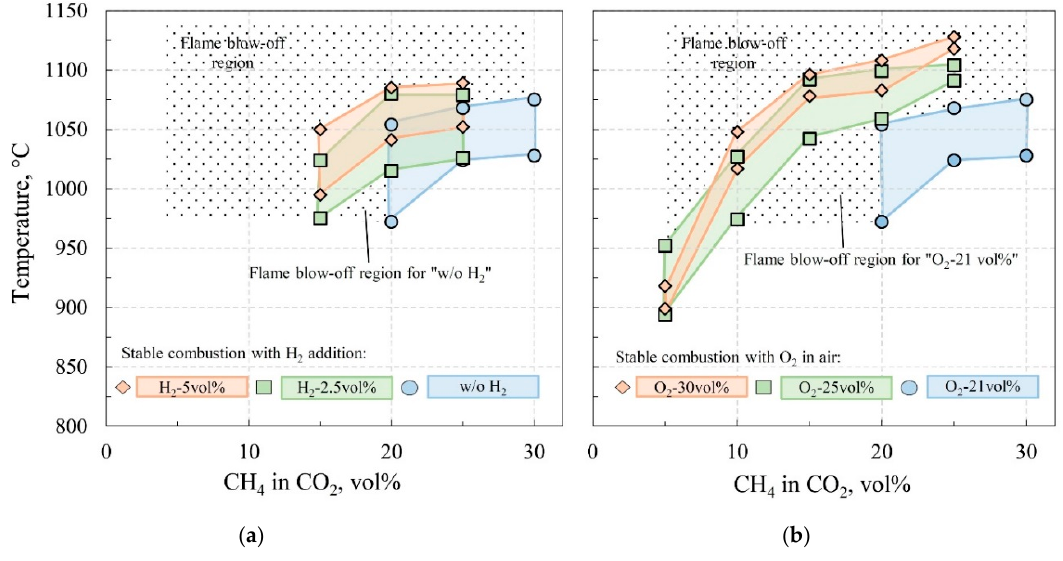
Figure 4. Temperature ranges during waste biogas (LCV) combustion with different content of CH 4 in CO 2 for a range of ( a ) H 2 addition and ( b ) O 2 air enrichment. The upper and bottom limit stands for a ϕ max and ϕ min , respectively.